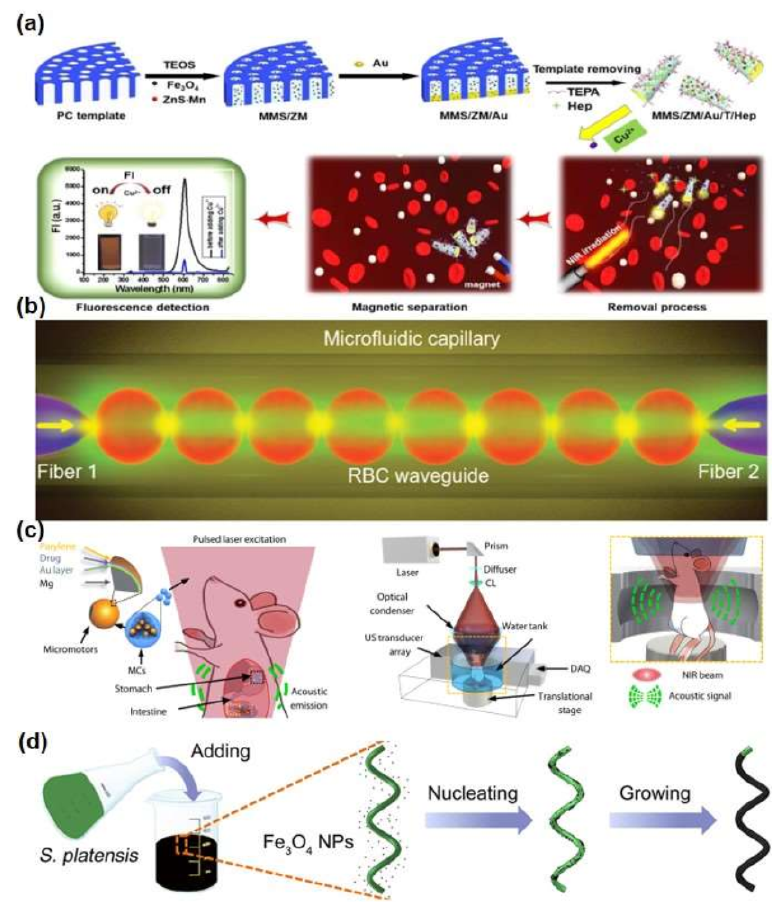
Figure 3. Design and fabrication of micro/nanorobots in medical diagnosis. ( a ) Schematic illus- tration of the synthesis of MMS/ZM/Au/T/Hep micromotors for blood Cu 2+ removal/detection treatment [35], copyright 2020, Elsevier; ( b ) schematic illustration showing the optical assembly of the RBC waveguide using two fiber probes in a microfluidic capillary [38], copyright 2019, Wiley- VCH; ( c ) schematic of the PAMR in the GI tract [41], copyright 2019, American Association for the Advancement of Science; ( d ) schematic of the dip-coating process of S. platensis in a suspension of Fe 3 O 4 NPs [43], copyright 2017, American Association for the Advancement of